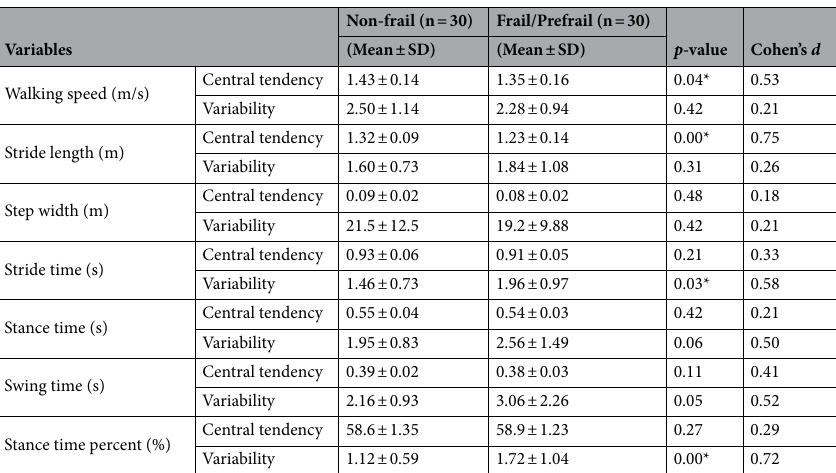
Table 3. Results of the central tendency and the variability (coefficient of variation) of the spatiotemporal parameters. The “*” symbol indicates significant differences between the non-frail and frail/prefrail groups (* p <